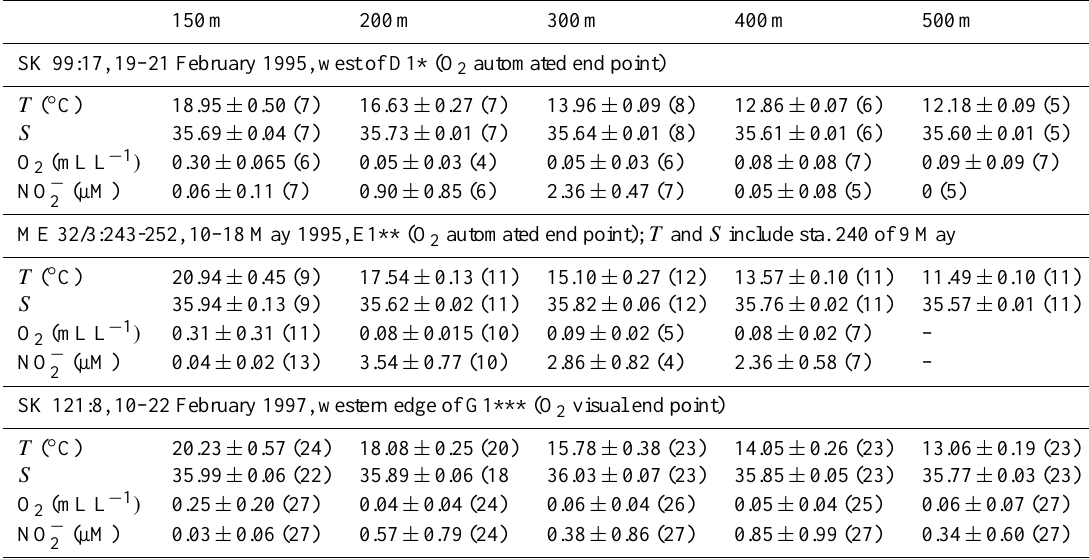
Table 3. Mean values with SD on drift stations (number of samples in